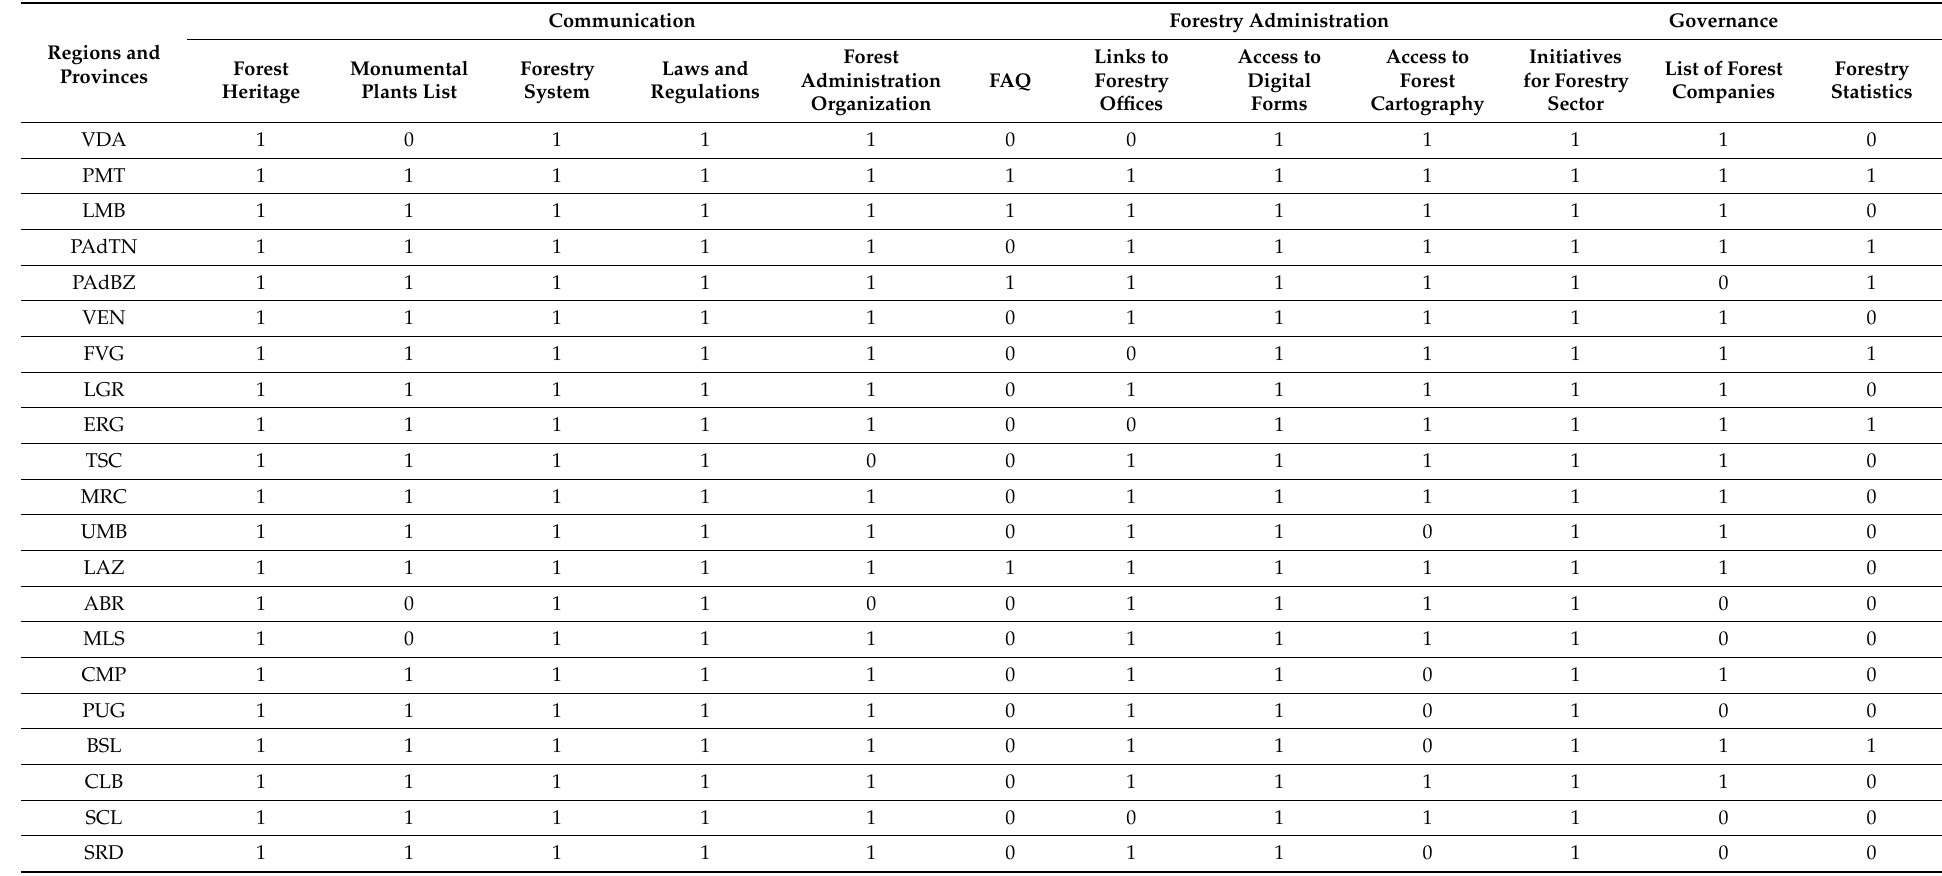
Table 1. Outcomes of institutional website